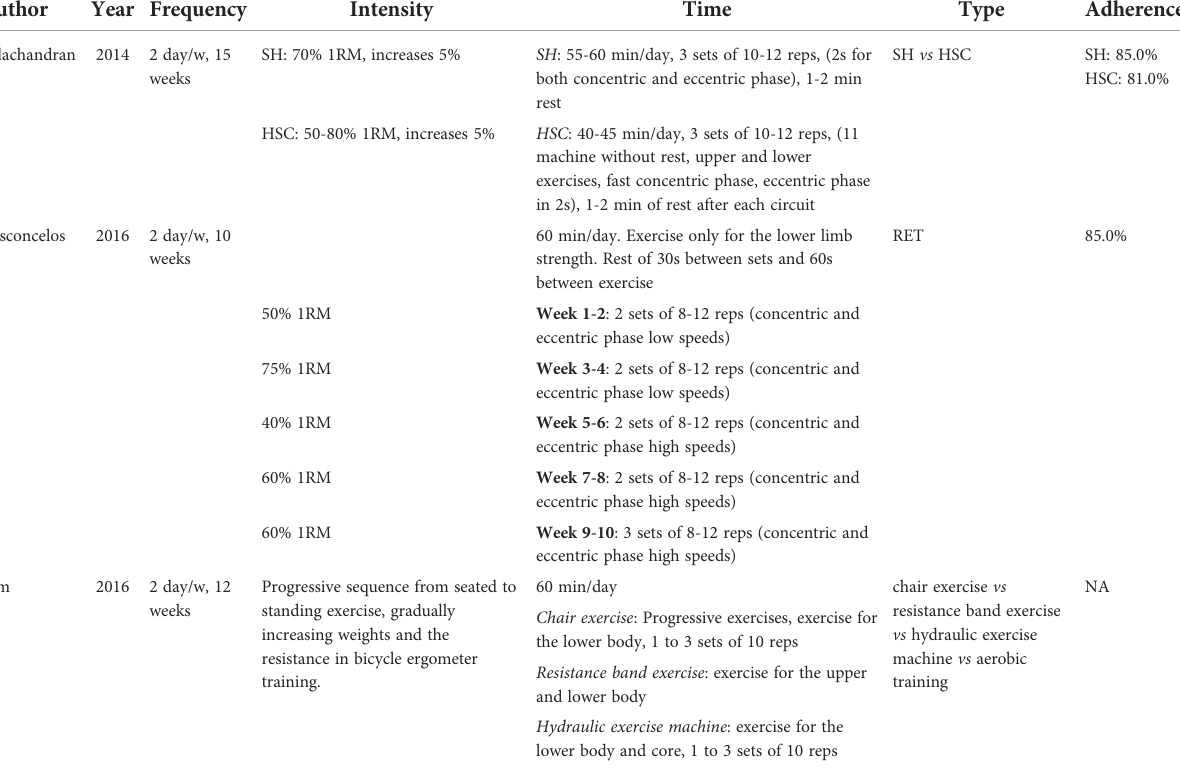
TABLE 3 Training protocol according to the FITT